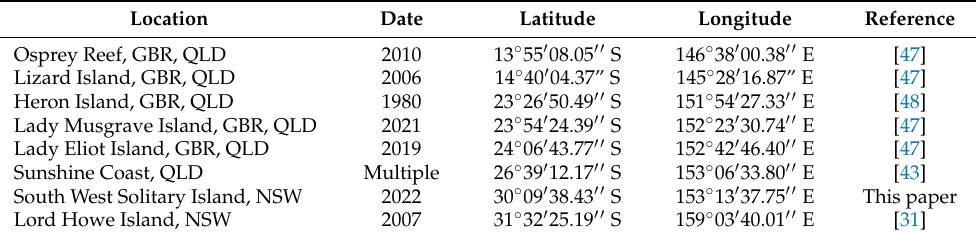
Table 5. Selected East Australian distribution records of Goniobranchus kuniei .